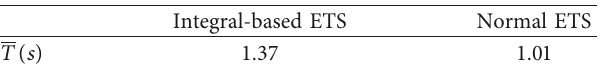
Figure 7: The comparison of release time intervals. Table 1: Average triggering time intervals, T ( s ) . Integral-based ETS Normal ETS T ( s ) 1.37 1.01